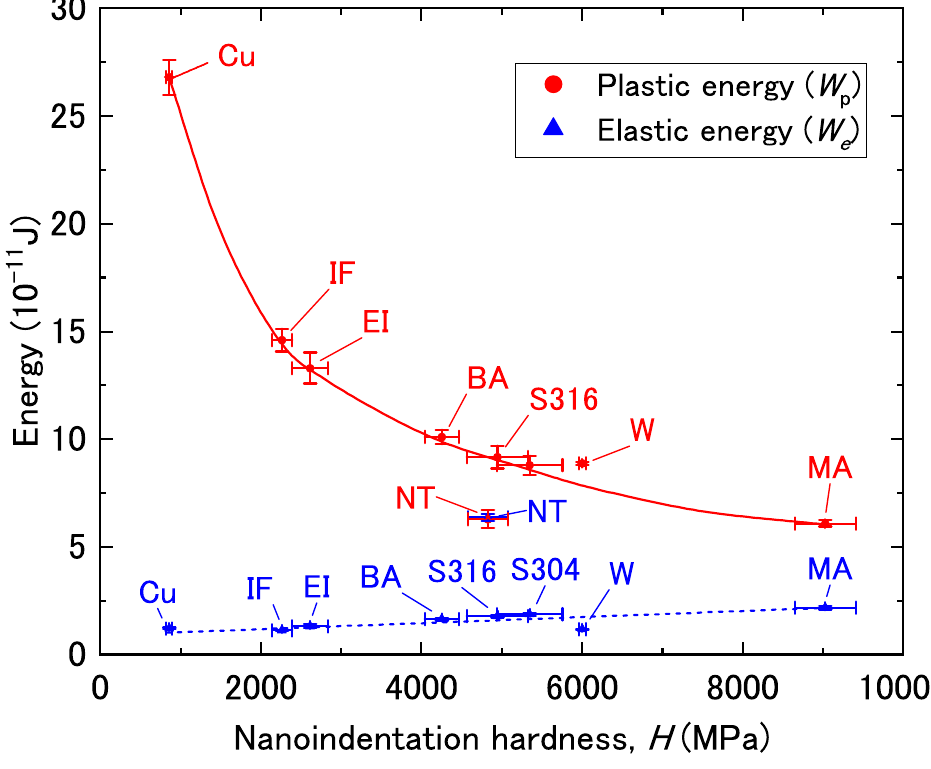
Figure 4. Elastic energy ( W e ) and plastic energy ( W p ) as a function of nanoindentation hardness ( H ). The error bars are drawn with the standard deviation.